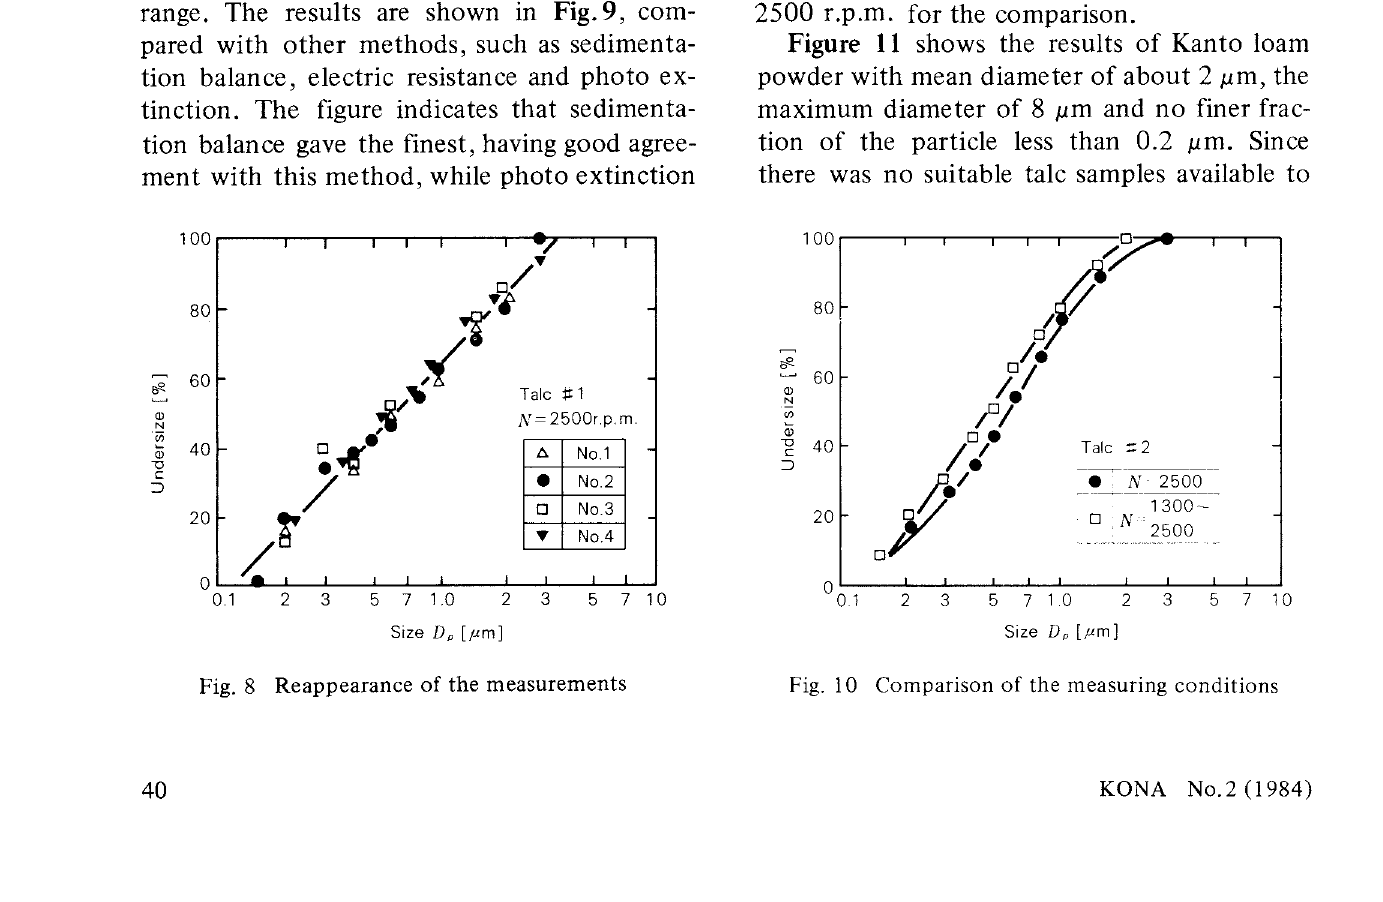
Fig. 10 Comparison of the measuring